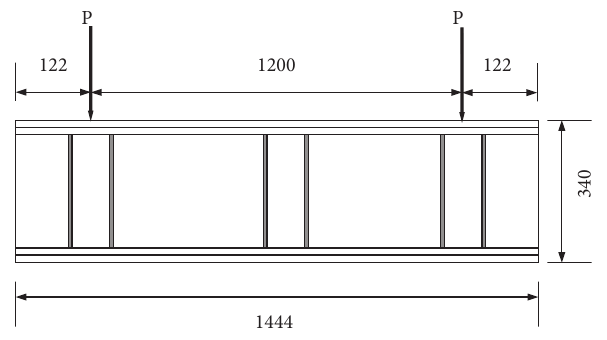
Figure 10: Cross section of the lower reaction